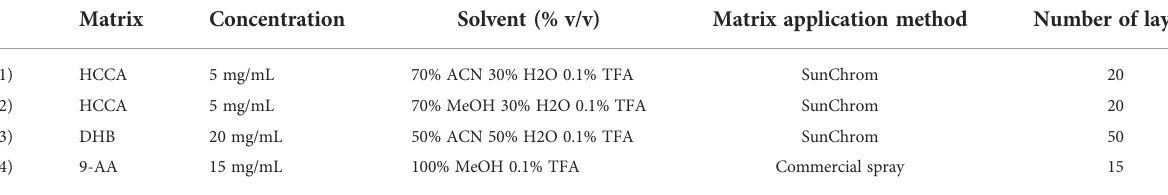
TABLE 1 Different matrices, concentrations and layers used in Vitis vinifera ‘ Trincadeira ’ leaf